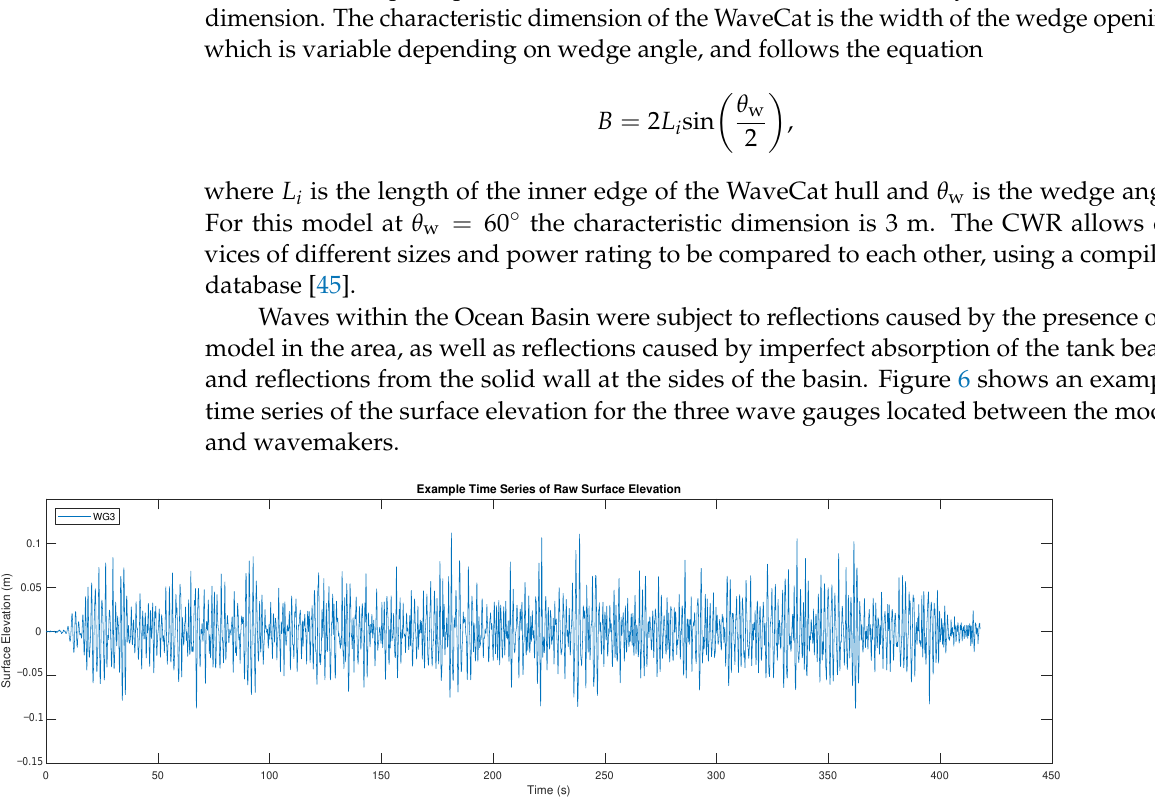
Figure 6. Example time series of surface elevation for the wave gauge located between the model and wavemakers, closest to the